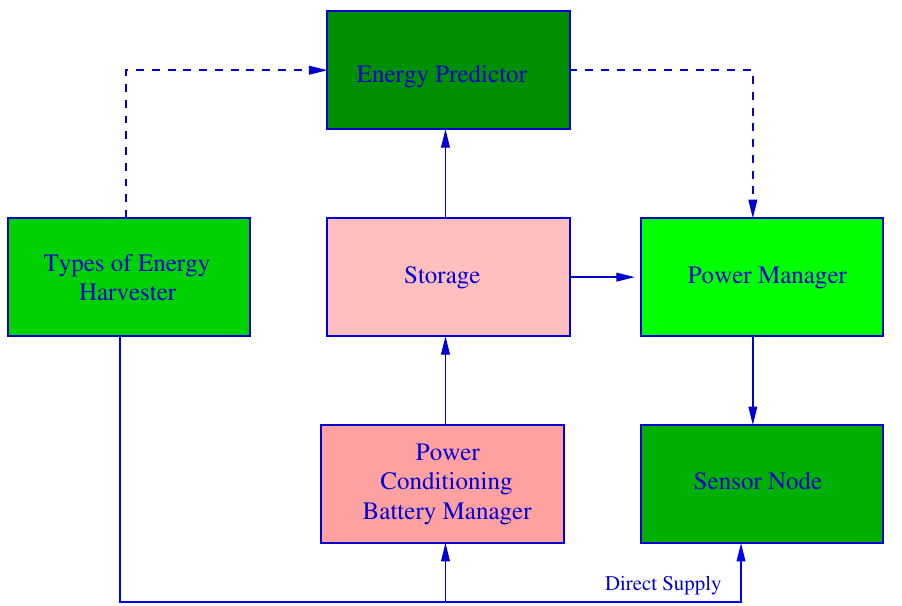
Figure 6. Components of a EH-WSN system. Adapted from